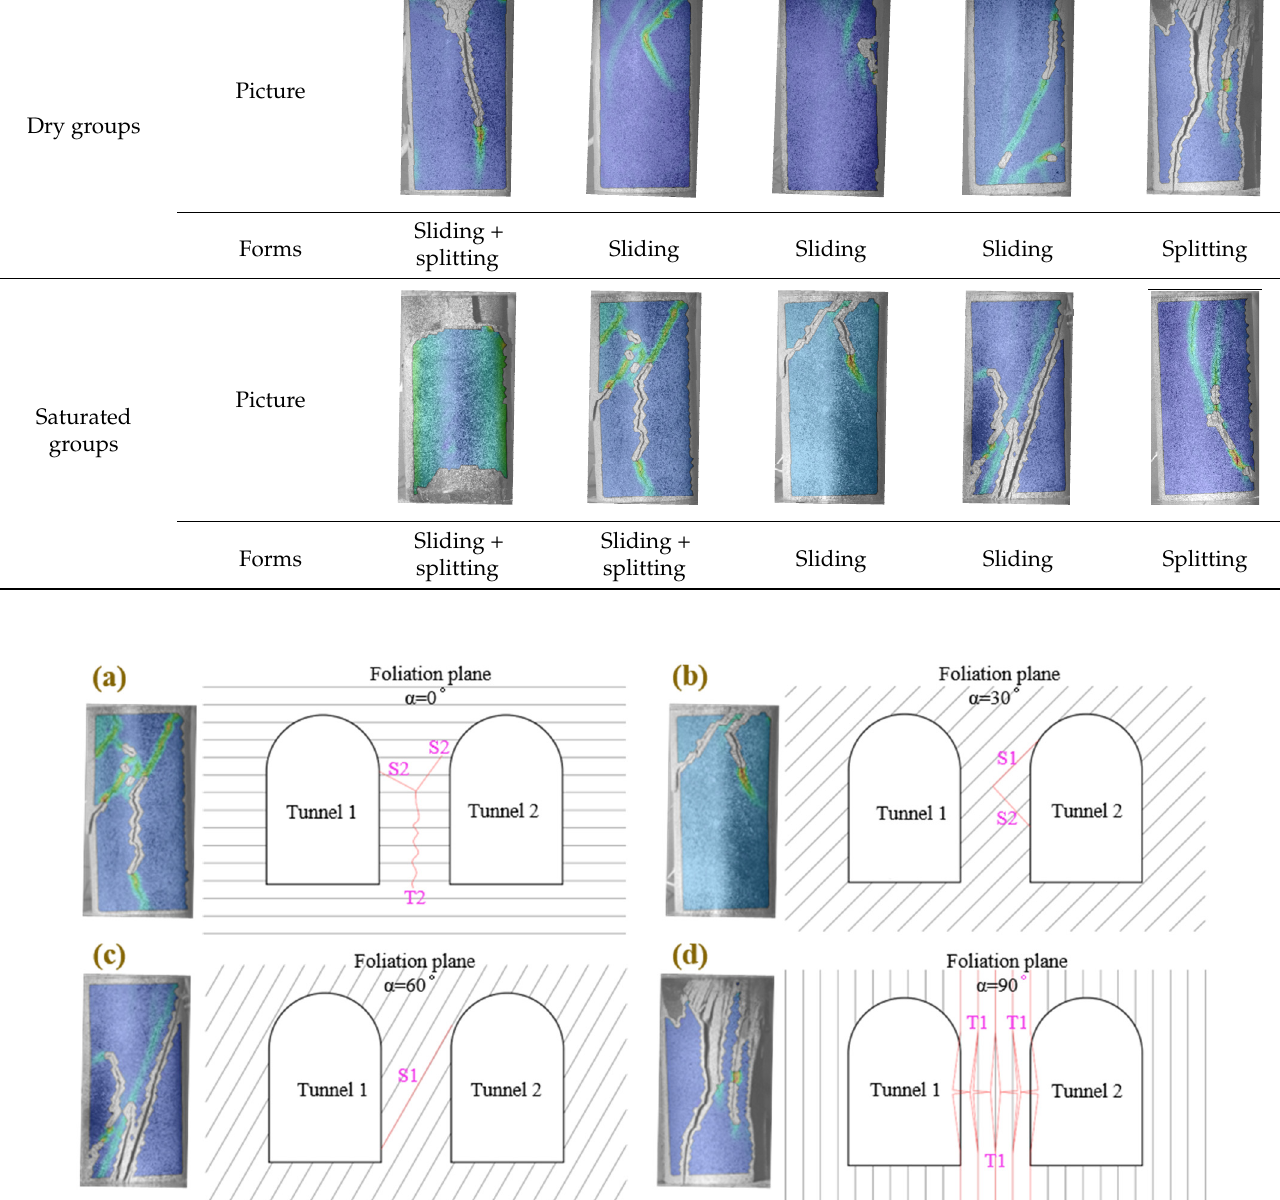
Table 2. Ultimate failure modes of foliated phyllite with different foliation angles.